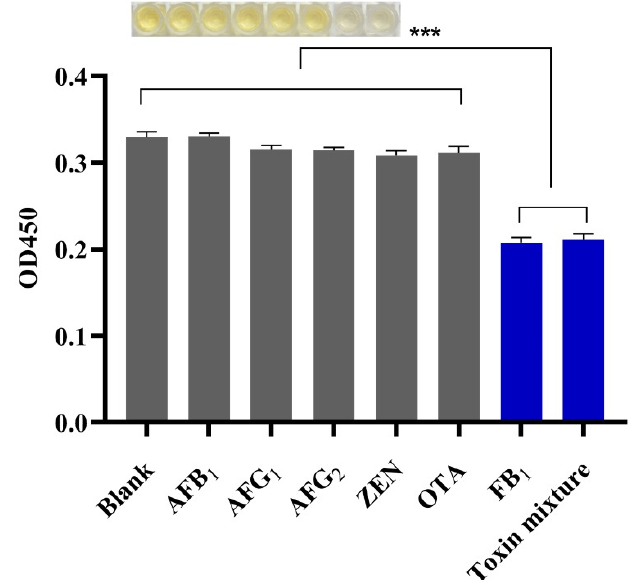
Figure 4. Specific detection. (Toxin mixture include AFB 1 , AFG 1 , ZEN, OTA and FB 1 , *** p <